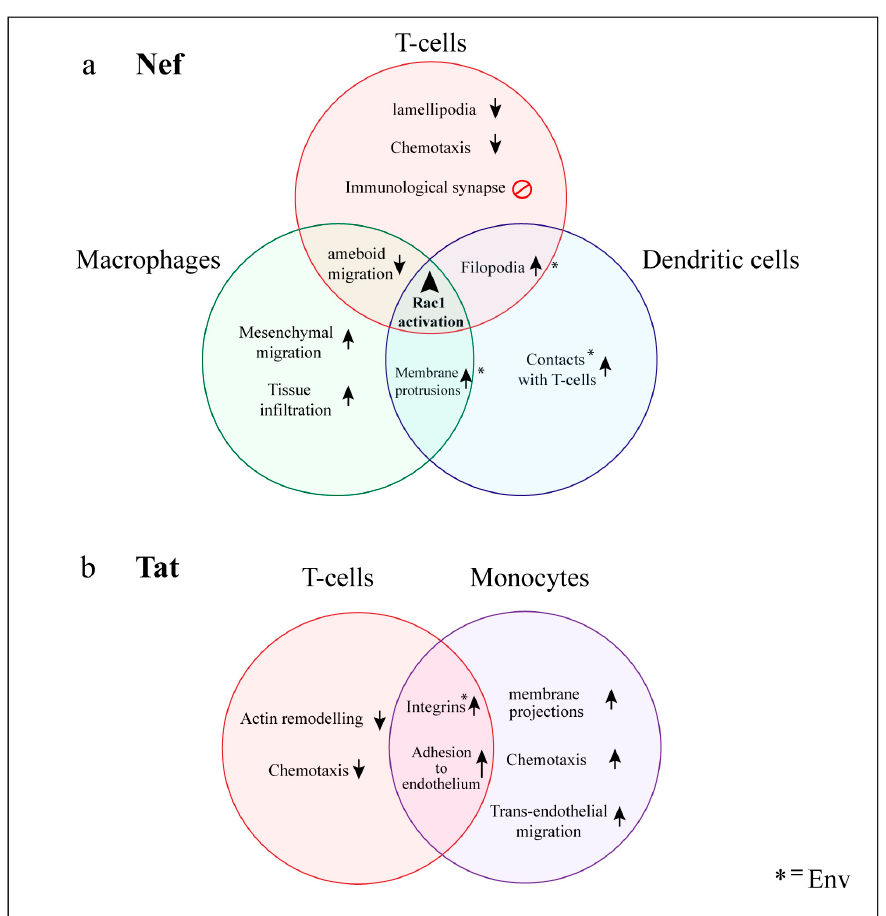
Figure 4. Actin-related changes in cellular behavior induced by HIV in relevant cell types. Coordinated manipulation of actin regulators results in global and cell-type specific changes in cellular morphology and motility that contribute to viral spread, impairment of immune function and HIV comorbidities. Many of these changes can be mapped to specific HIV accessory proteins, which act as master regulators of the cytoskeleton. Nef and Tat are expressed in HIV-infected cells but are also present extracellularly in serum and, thus, can affect both infected and uninfected cells. ( a ) Nef; leads to Rac1 activation in a wide range of cell types. In T-cells, this is associated with inactivation of Cofilin and severe cytoskeletal disorganization, which impairs cell migration and immunological synapse formation. In myeloid cells, Nef enhances formation of several membrane protrusions which promote cell motility and contacts with uninfected cells; ( b ) Tat modulates the expression of numerous genes involved in actin regulation. In T-cells, Tat interferes with chemotaxis and F-actin remodeling, whereas in monocytes it increases cell motility, chemotaxis and phagocytosis. Tat also induces expression of adhesion molecules and promotes leukocyte binding to the endothelium. Upward arrows represent enhancement of biological processes or increases in number of structures, whereas downward arrows represent impairment of processes. * = Effects also induced by HIV envelope glycoprotein (Env).